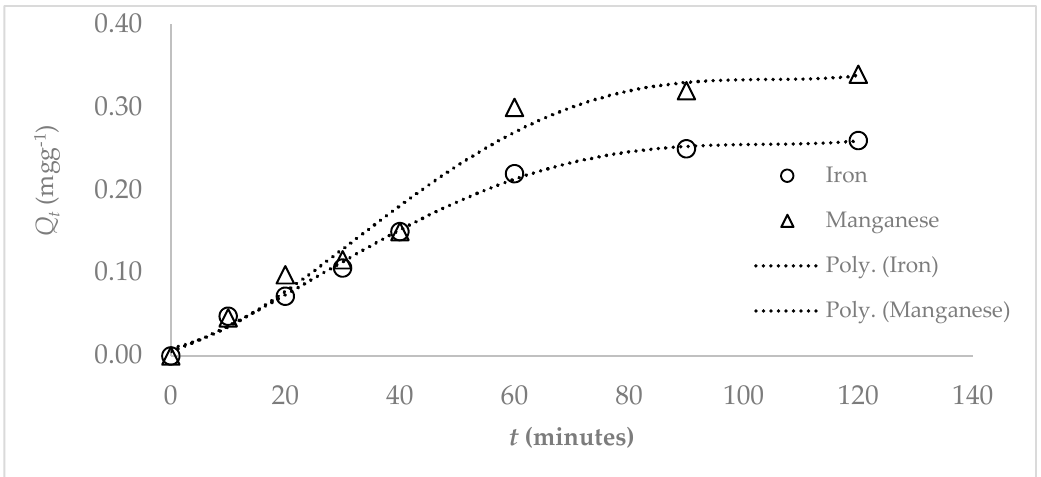
Figure 7. Graph obtained for iron and manganese uptake onto zeolite Y during adsorption studies with time. Initial Fe = 1.15 mg L − 1 ; Initial Mn = 1.61 mg L − 1 ; adsorbent dose = 2.5 g L − 1 , T = 25 °C; water pH = 6.5. Table 4. Adsorption isotherms parameters for iron and manganese onto zeolite Y. Langmuir Freundlich